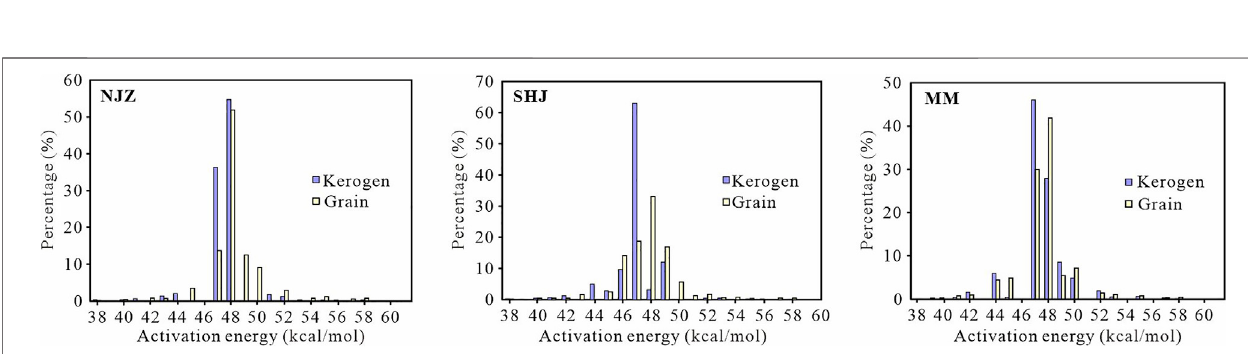
Frontiers in Earth Science |